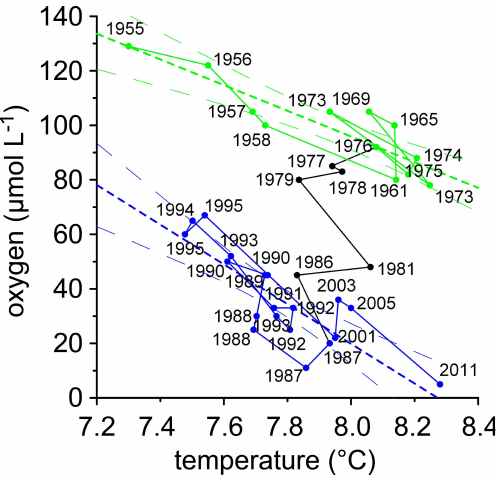
Fig. 14. Relationship between basin-averaged oxygen concentra- tion and water temperature in the main pycnocline of the Black Sea (sigma- t = 15.4) from 1955–2011. Individual points represent the mean oxygen concentrations measured during individual cruises; thus they are available only for years when cruises were carried out. The dashed lines with short dashes represent linear regressions of the data from 1955–1979 and 1981–2011, and the dashed lines with long dashes represent the corresponding confidence